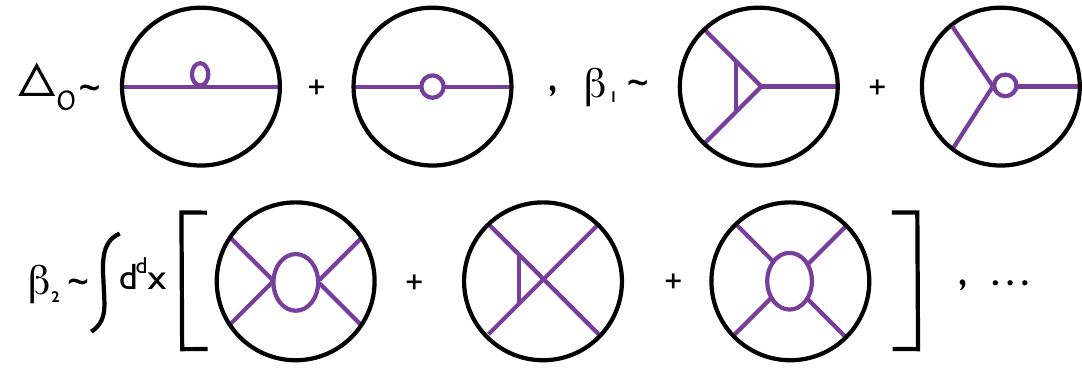
Figure 9. One-loop Witten diagrams contributing to (cid:1) O , (cid:12) 1 and (cid:12) 2 . Cubic and quartic Witten diagrams should include also those with loop corrections to propagators, but we have not drawn them